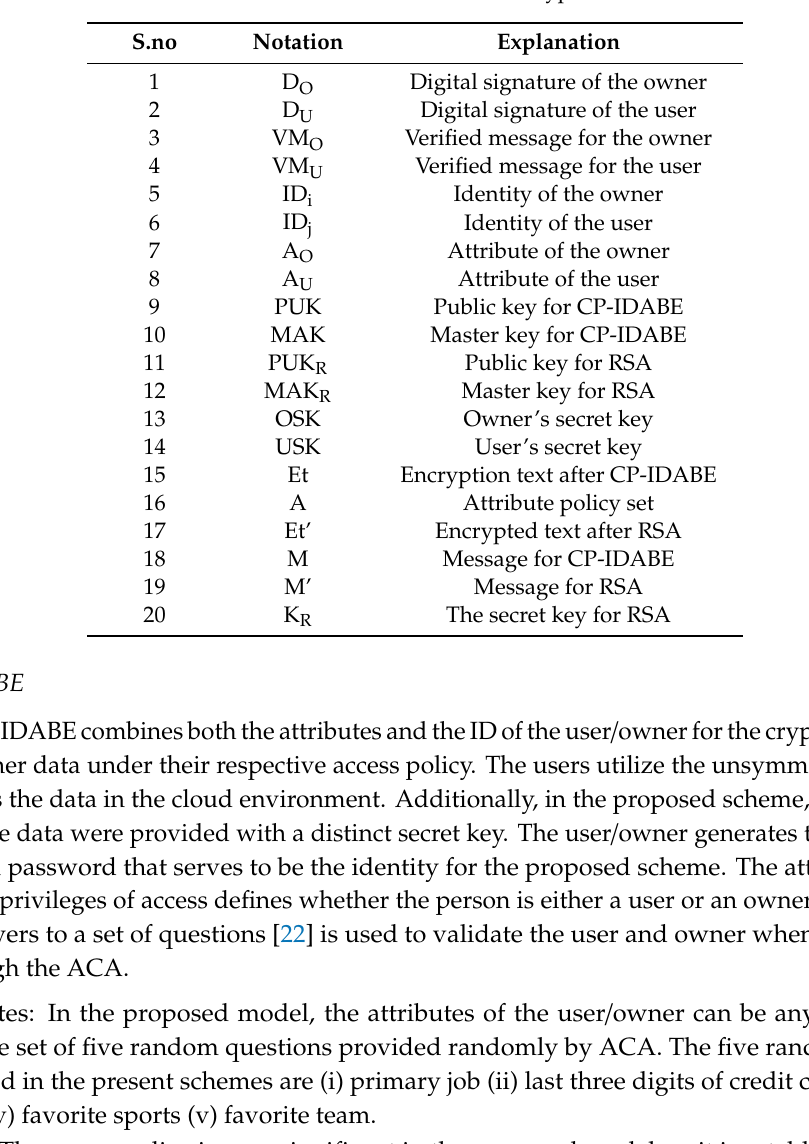
Table 1. Notations used in the CP-IDABE cryptic